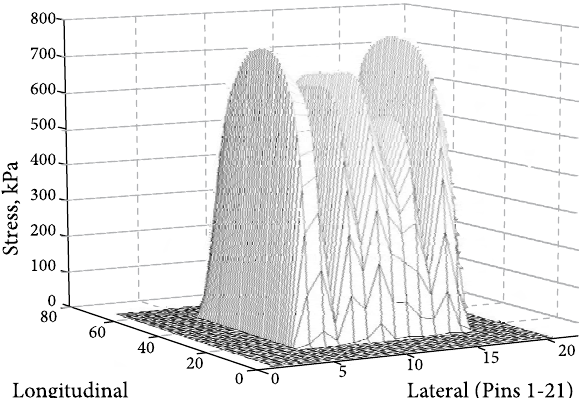
Table 2. Pavement structures analyzed Case No.